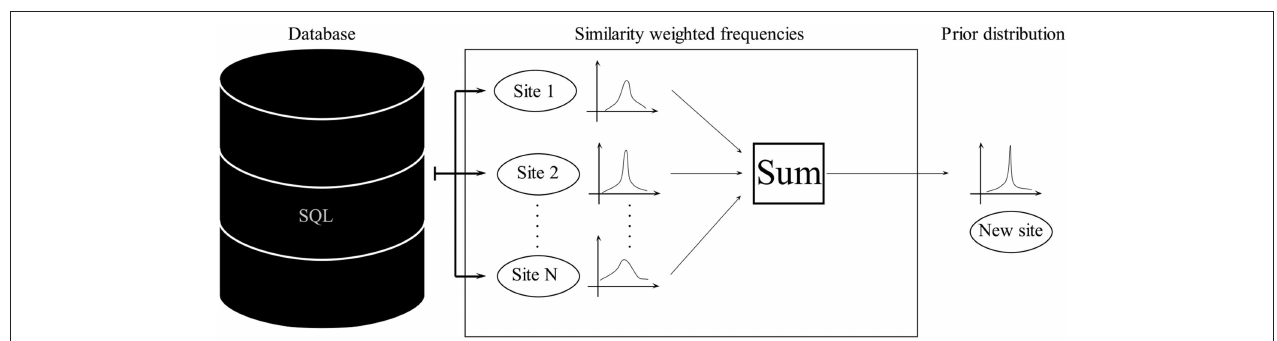
FIGURE 2 | Schematic of prior derivation machine learning tools.